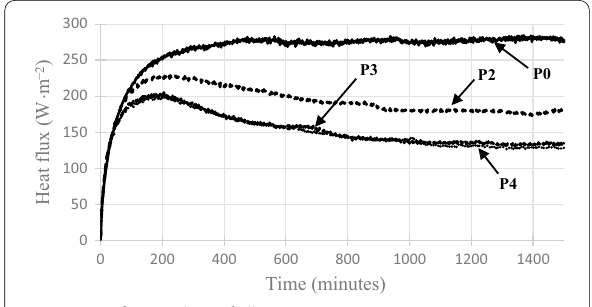
Fig. 7 Heat flux reading of all